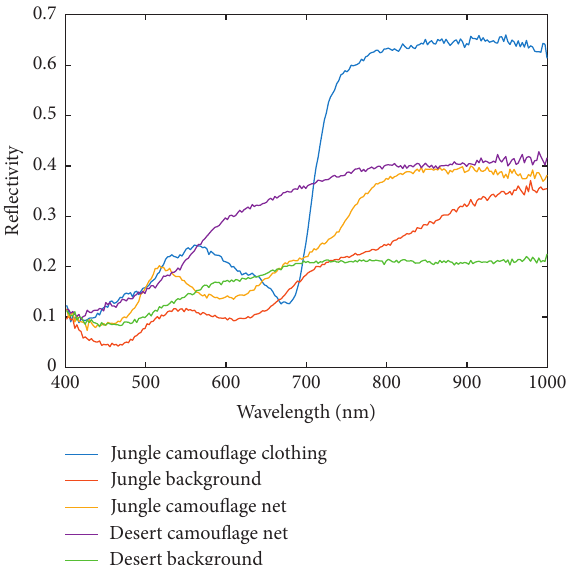
Figure 7: Referenced spectral curves of desert background, desert camouflage netting, jungle background, jungle camouflage netting, and jungle camouflage